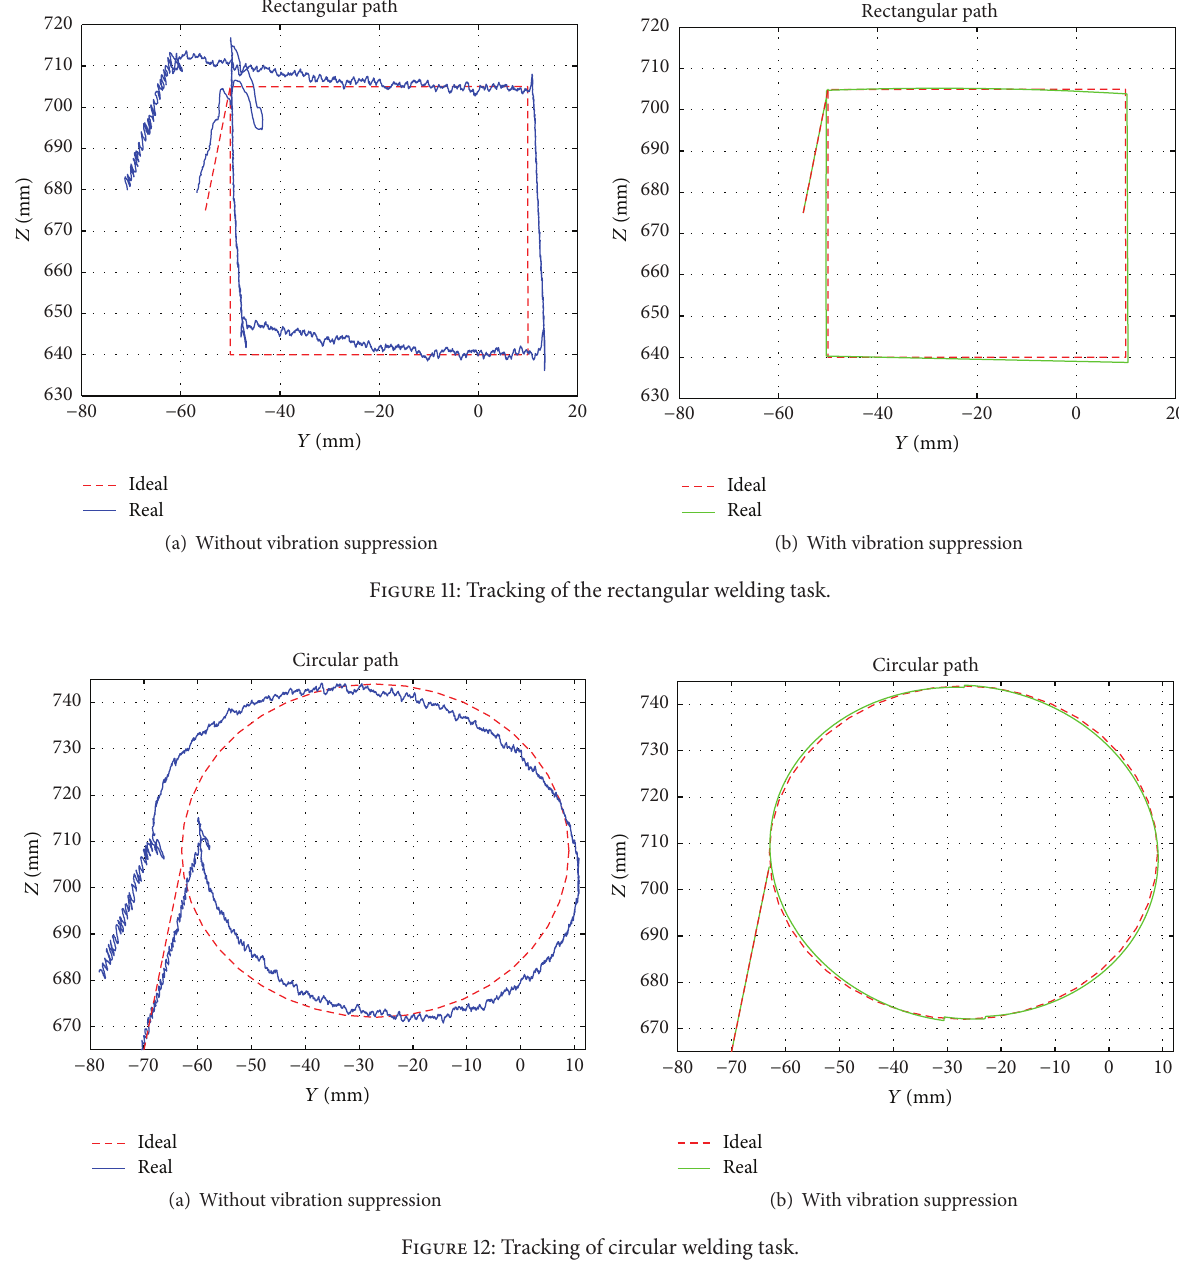
Figure 12: Tracking of circular welding